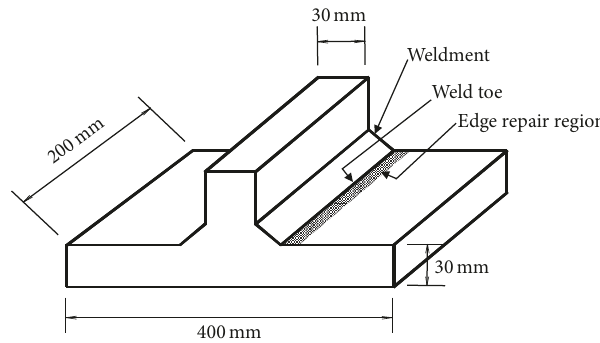
Figure 4: T-butt dimensions showing edge repair region and weld